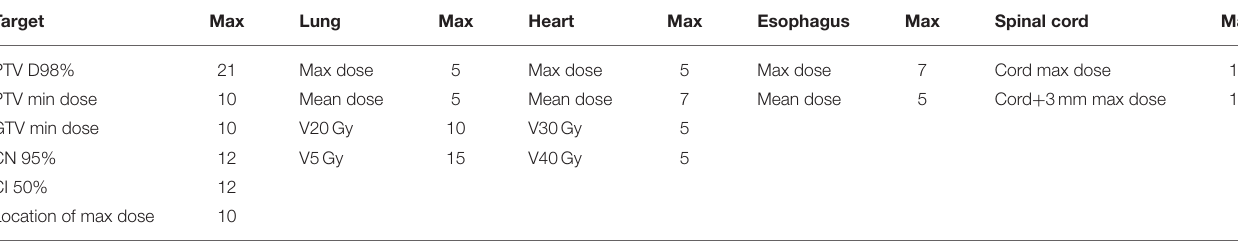
TABLE 1 | Metrics chosen to be a part of the scoring system and their respective maximum point value.